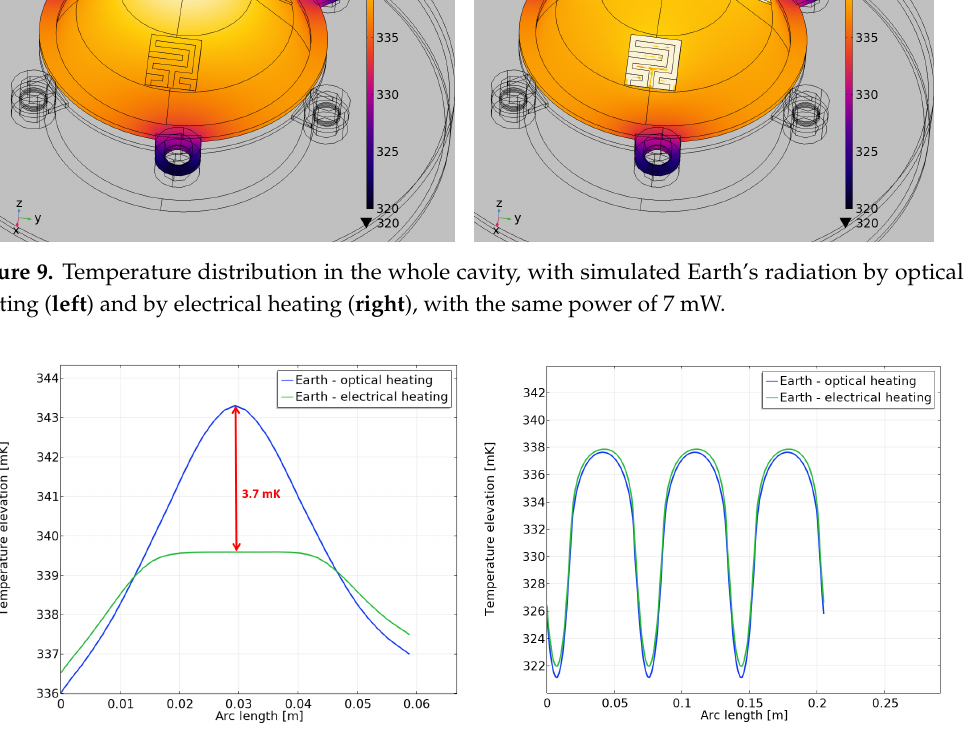
Figure 10. Temperature distribution along the spherical part of the cavity with simulated Earth’s radiation, passing through the top of the cavity ( left ) and along the three heat sinks of the cavity ( right ), for both optical and electrical